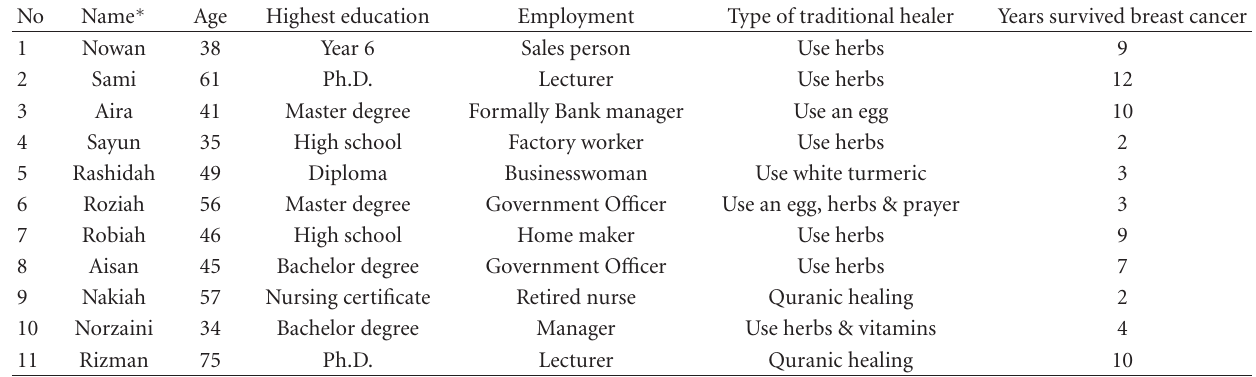
Table 1: Profile of